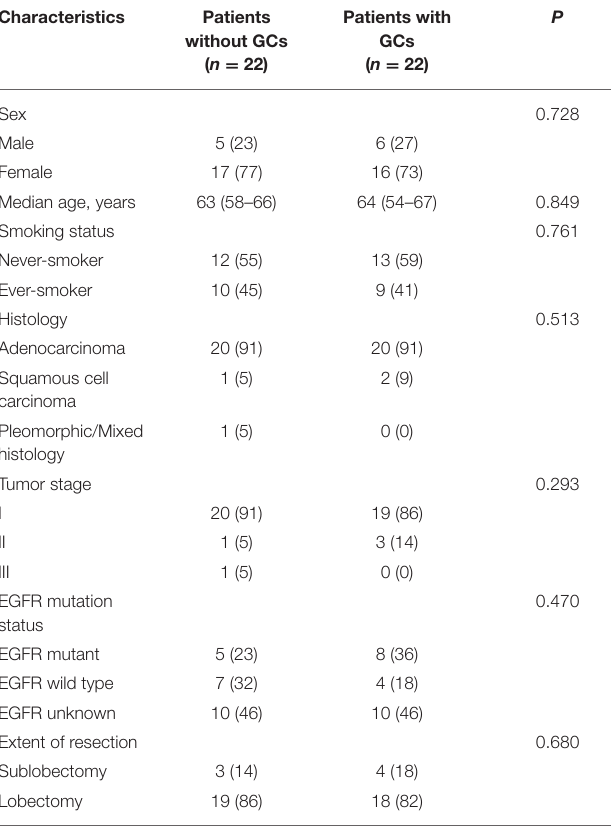
TABLE 3 | Baseline characteristics after propensity-matching adjustment of confounding covariates.